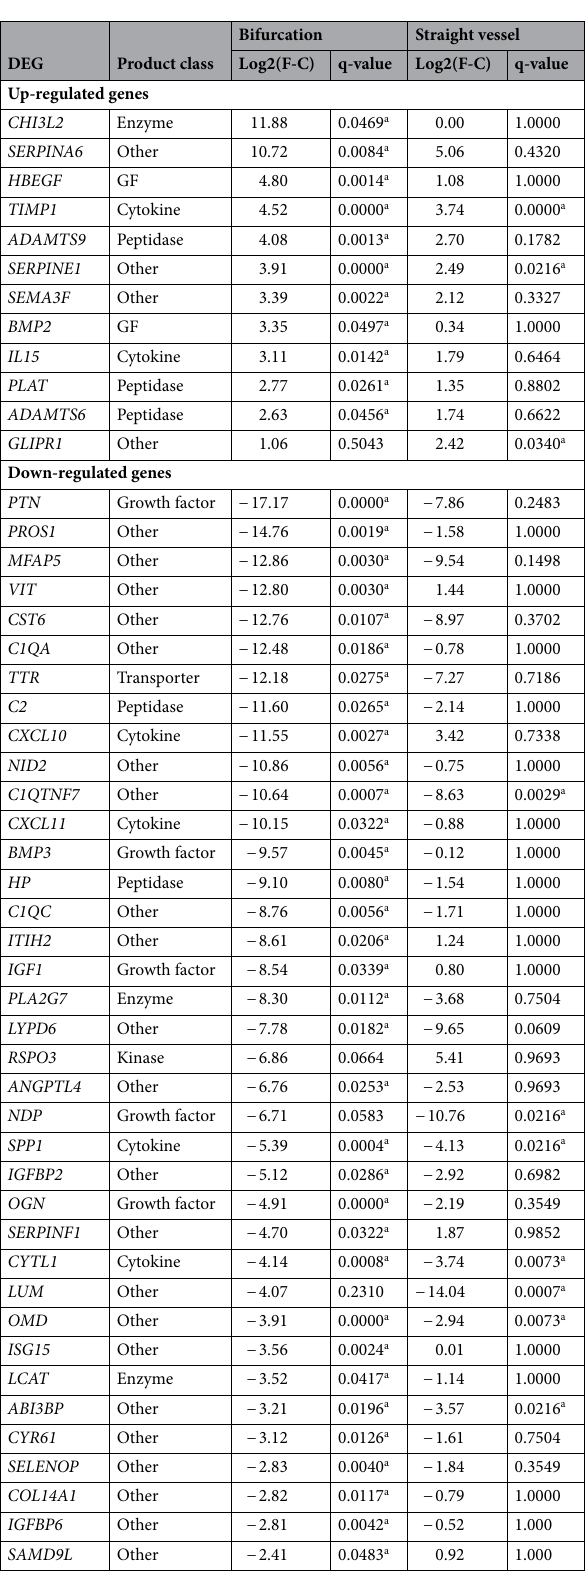
Table 1. Intimal DEGs encoding extracellular products. All genes whose expression was significantly different between ligated and unligated animals in the intima of bifurcations (BT) or straight vessels (BA) and whose product was classified as extracellular in the Ingenuity Pathway Analysis database are listed. DEG differentially expressed gene, F-C fold-change. a Significantly different expression between ligated and